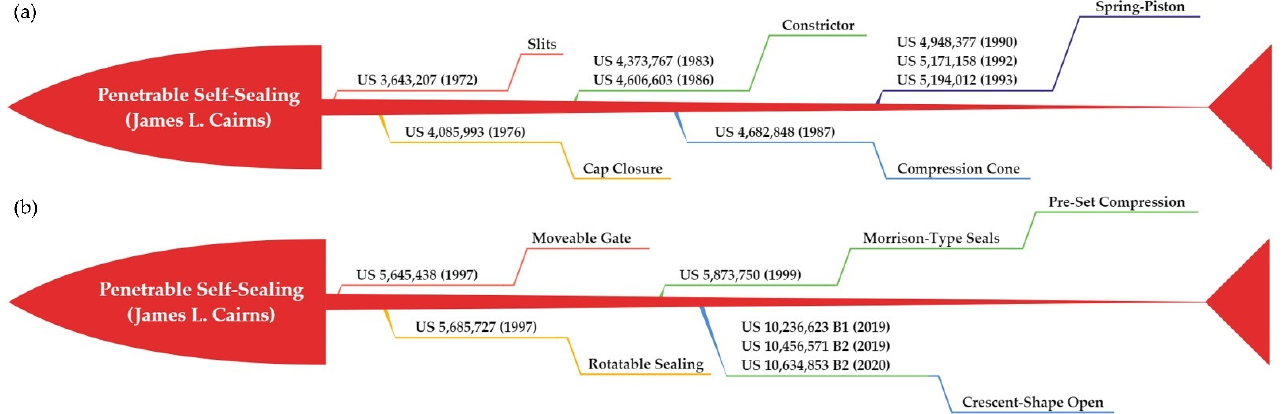
Figure 14. Technology evolution map of penetrable self-sealing: ( a ) from the 1970s to the early 1990s, and ( b ) from the late 1990s to the 2020s.